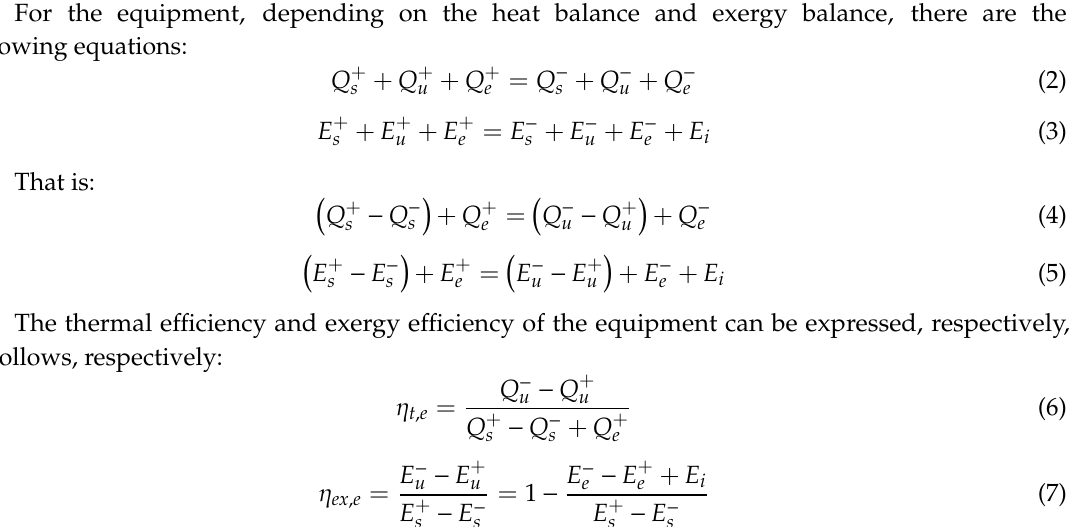
Figure 2. Energy use model [24]. Q + user and environment, respectively. Q − environment by the equipment, respectively. E + by the energy, user and environment, respectively. E − user and environment by the equipment, respectively. E i : Internal exergy loss of the equipment.